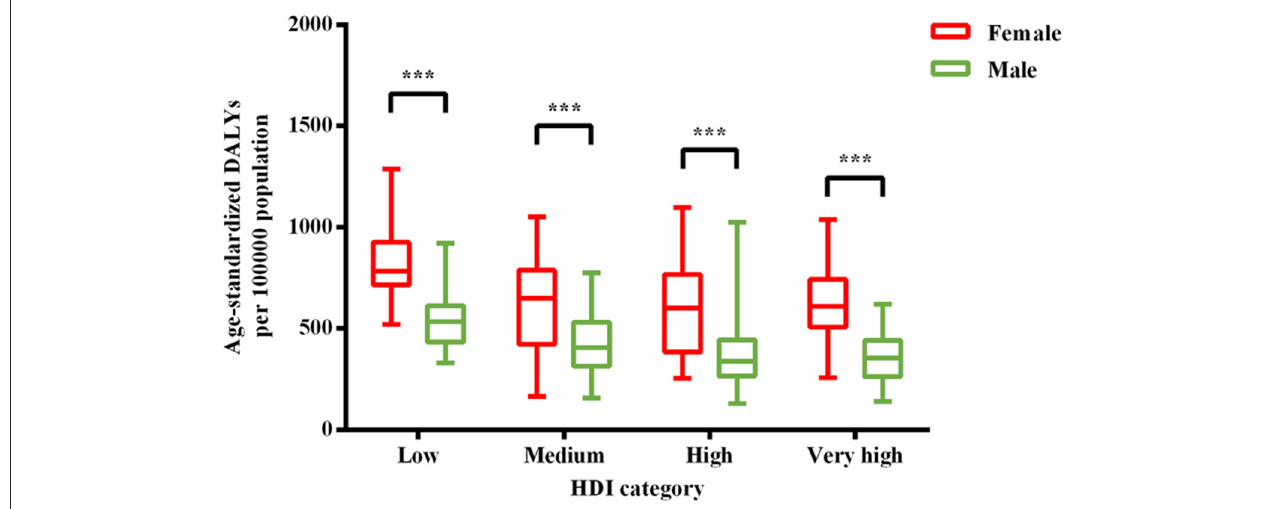
FIGURE 4 | Age-standardized DALY rates among female population were higher than that among male population for each HDI-based country group. Lines inside the boxes indicate the medians; boxes, the 25th and 75th percentiles; and lines outside the boxes, the minimum and the maximum. *** P < 0.001.